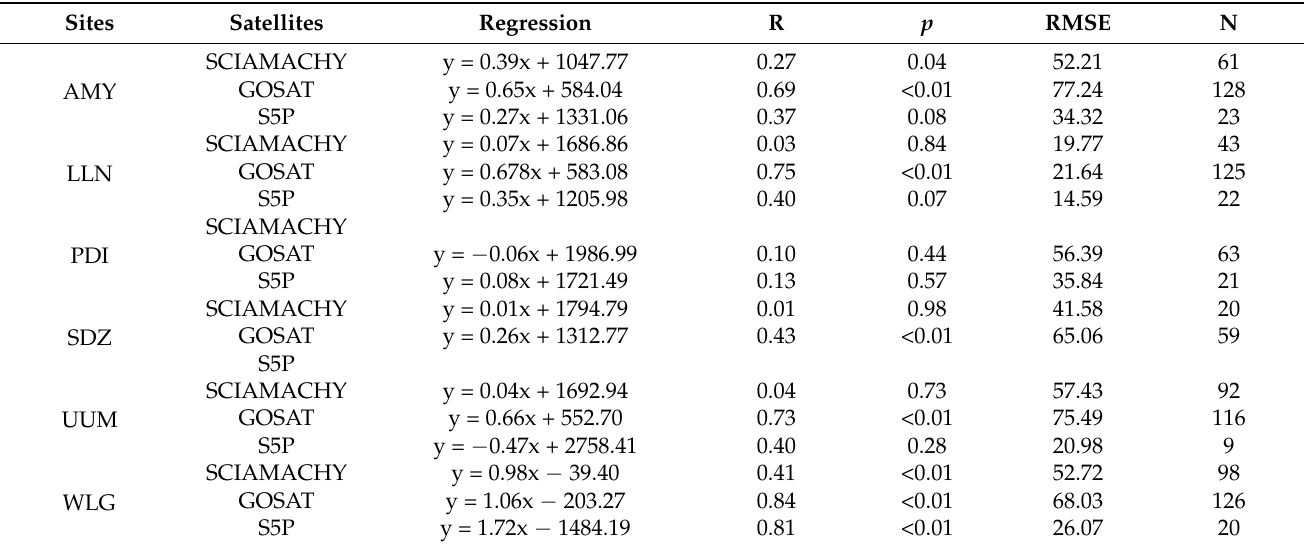
Table 1. The correlation between satellite-observed XCH 4 concentrations and ground measurement of CH 4